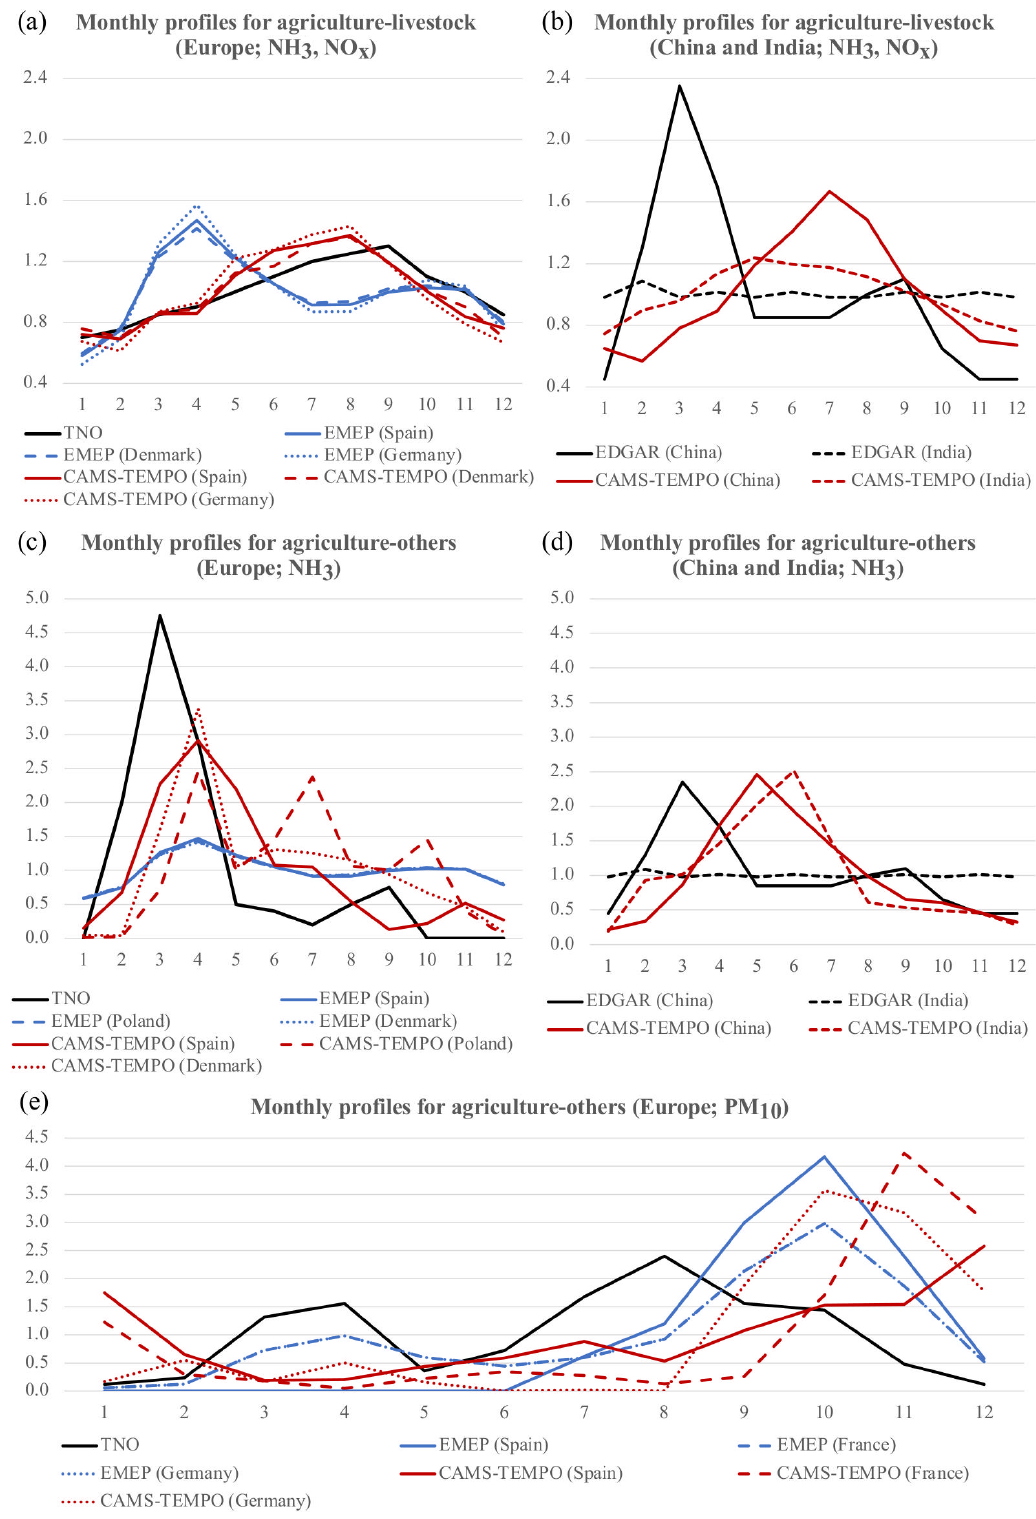
Figure 15. Comparison of monthly profiles for agricultural emissions developed in the present work (CAMS-TEMPO) with profiles from EDGAR, EMEP and TNO for selected countries and categories: NH 3 livestock emissions in Europe (a) and China and India (b) , NH 3 other agricultural emissions in Europe (c) and China and India (d) , and PM 10 other agricultural emissions in Europe (e) .